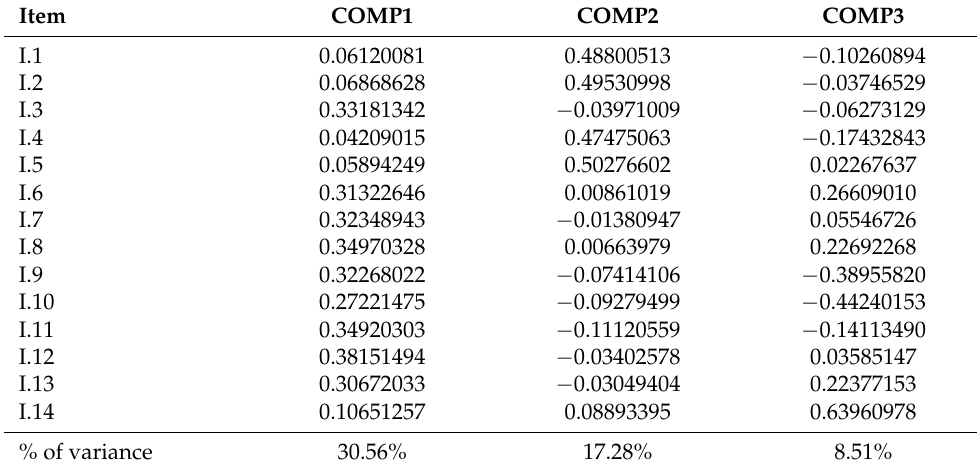
Table 8. Loading matrix of the PCA with WhatsApp Indian data.